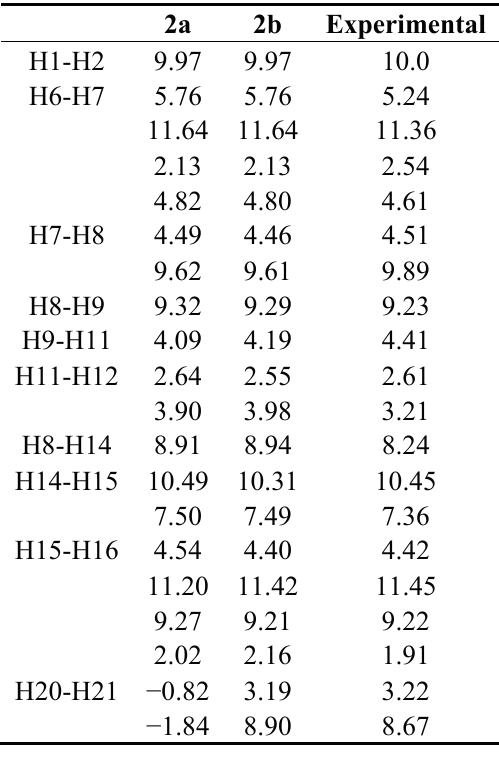
Table 4. Experimental and PCM calculated 3 J